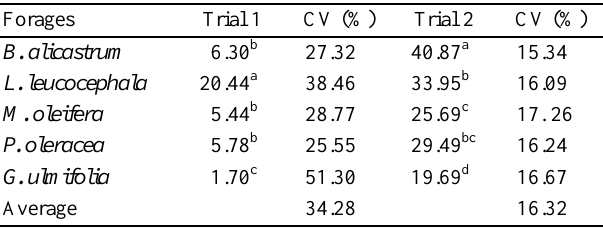
Table 5. Forage DMI (g/d) and CV% for each trial (n = 12 rabbits for each trial) Forages Trial